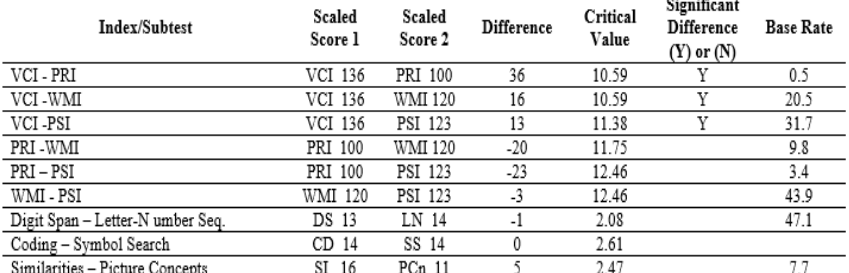
Table A-3. Discrepancy comparison